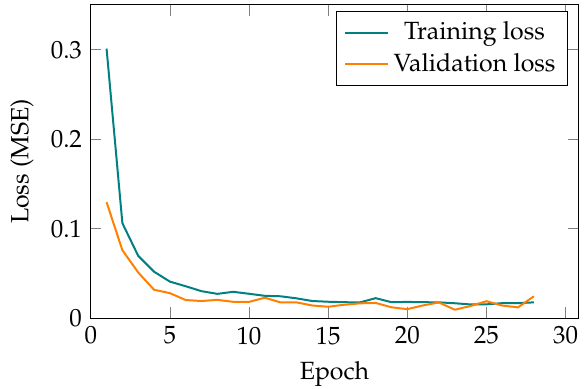
Figure 5. Learning curve of the AE for the spring movement. After training AEs, the training dataset is fed to the models and the mean absolute error (MAE) for data points is acquired. Moreover, the maximum MAE is used as the threshold for classifying a signal sequence as anomaly in binary classification case. The simulation results for sample MAE reconstruction errors can be seen in Figure 6.